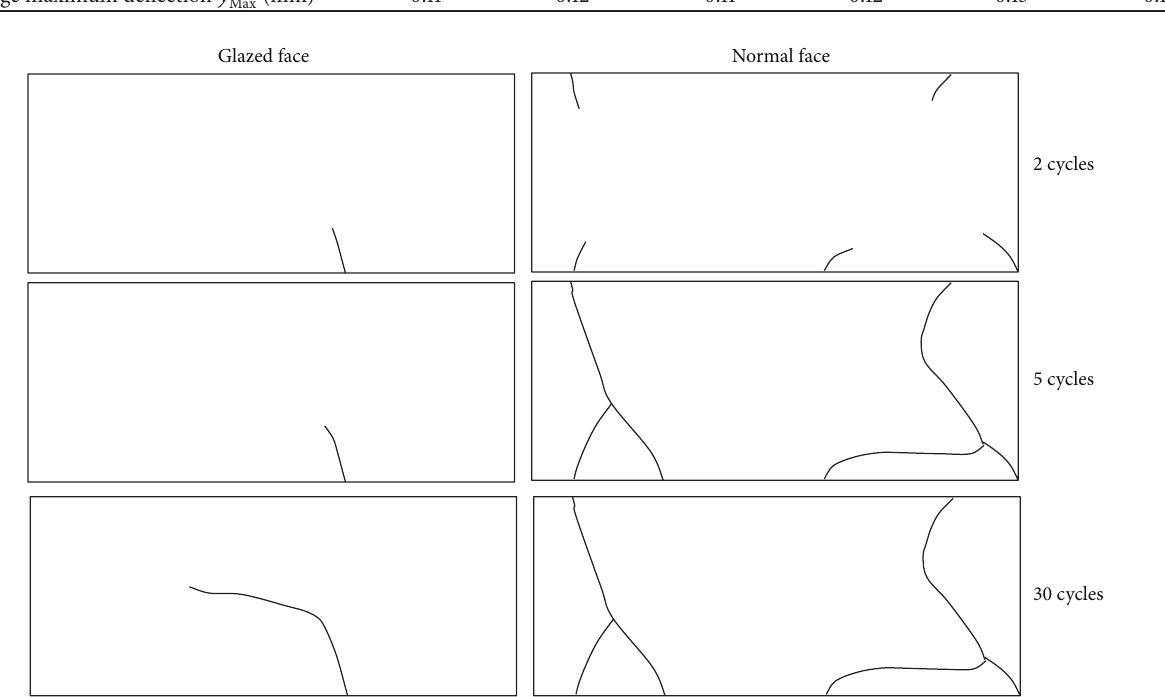
Figure 3: Surface cracks evolution by thermal shocks of the grade 302-3 at Δ𝑇 = 230 ∘ C.